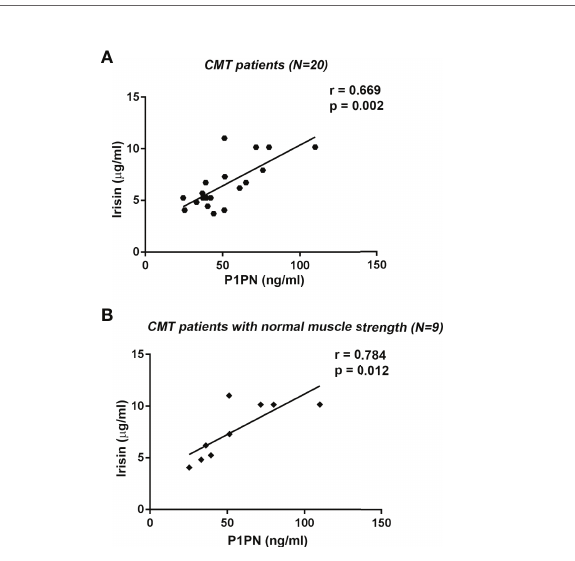
FIGURE 3 | Negative correlation between Irisin and 25(OH)-Vitamin D serum levels in CMT patients with Vitamin D de fi ciency (N = 19) (A) . Irisin serum levels negatively correlated with 25(OH)-Vitamin D in CMT patients with pathologic handgrip (N = 11) (B) . Linear regression, r and p values as